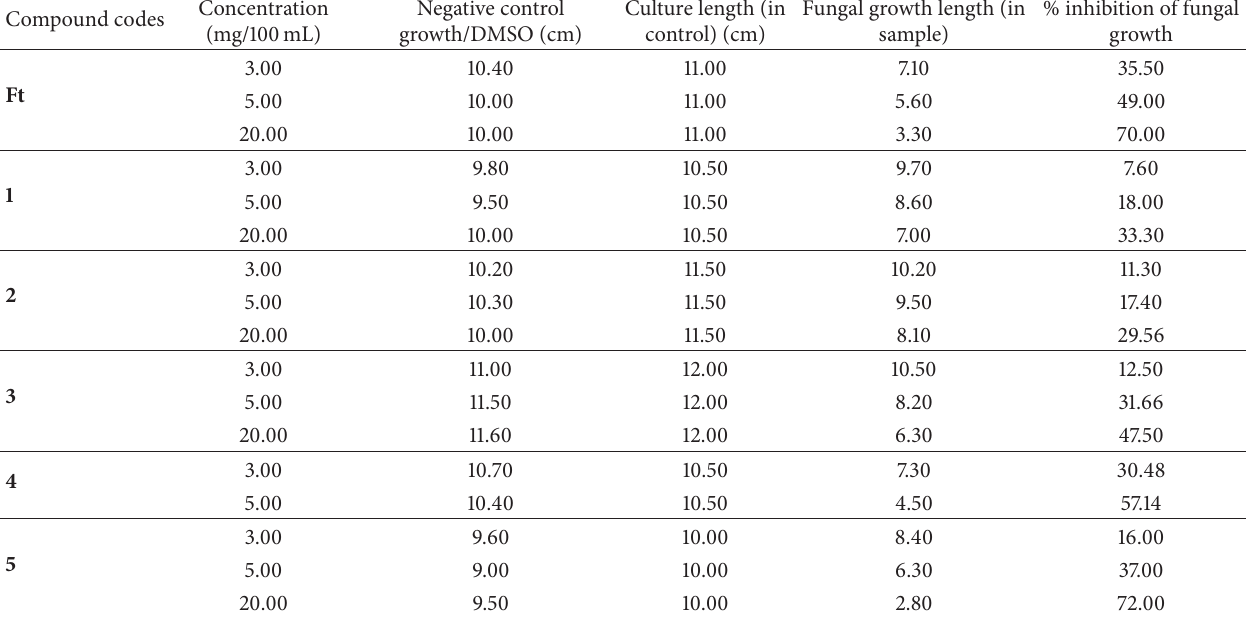
Table 3: Antifungal activity of Ft and 1–5 .